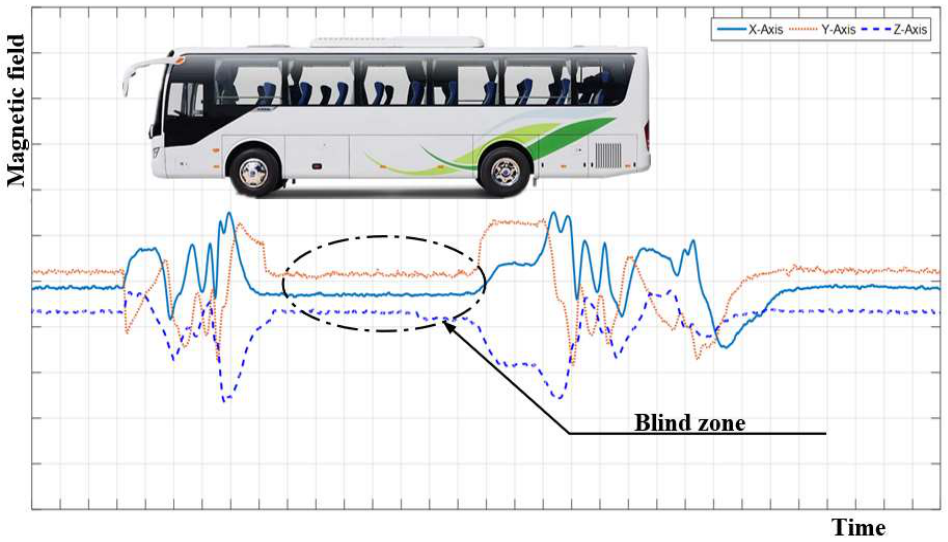
Figure 2. The magnetic signal blind zone problem of high chassis vehicles.